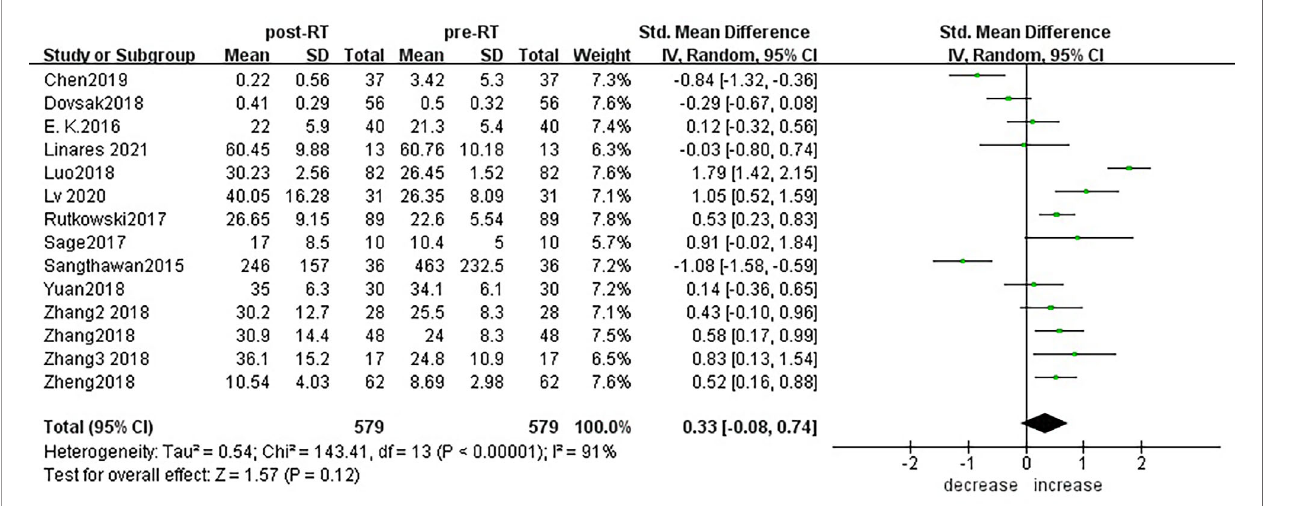
FIGURE 4 | Forest plot for changes of CD8+T lymphocytes after radiotherapy compared with before radiotherapy. decrease: CD8+T lymphocytes were less after radiotherapy than before. increase: CD8+T lymphocytes were increased after radiotherapy than